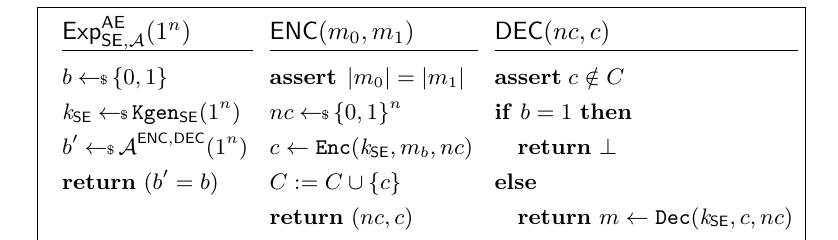
Figure 1: The Exp AE